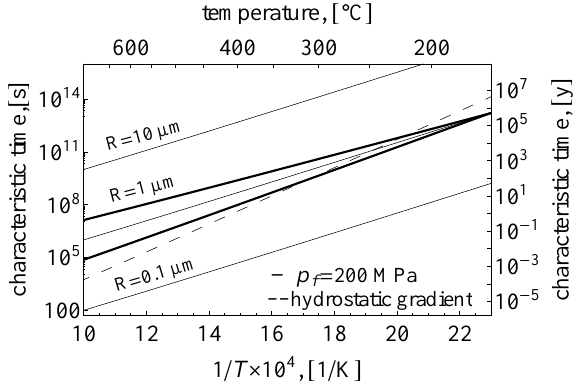
Figure 15. Prediction of characteristic time for crack healing ac- cording to Eq. (8) using the constraints on kinetic parameters for surface diffusion as rate-controlling mechanism (Table 3). Crack widths, i.e., radius of the ovulating cylinder, of 0.1, 1, and 10µm were considered in the calculations. Calculations were performed for a constant fluid pressure (solid lines) and a fluid pressure– temperature relation according to a geotherm of 30Kkm − 1 and a hydrostatic pressure gradient. The thick solid lines explicitly indi- cate the uncertainty in the prediction for a constant fluid pressure and a crack width of 1µm, resulting from the quoted uncertainty in kinetic parameters. A similar range is produced for the model with fluid pressure following a hydrostatic